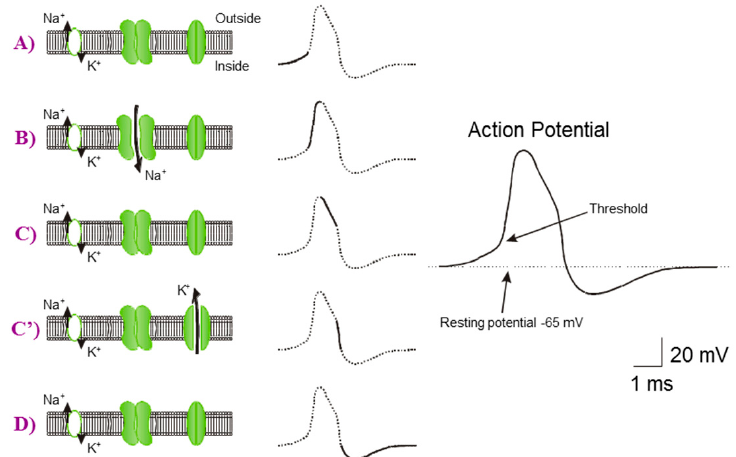
Figure 5. Description of the creation of action potential following the different ion interactions. ( A ) steady state of membrane voltage; ( B ) the opening of Na + ionic pump depolarizes the voltage membrane; ( C ) closing of Na + ionic pump; ( C’ ) the opening of K + ionic pump repolarizes the voltage membrane; ( D ) come back to the resting potential thanks to leakage current.